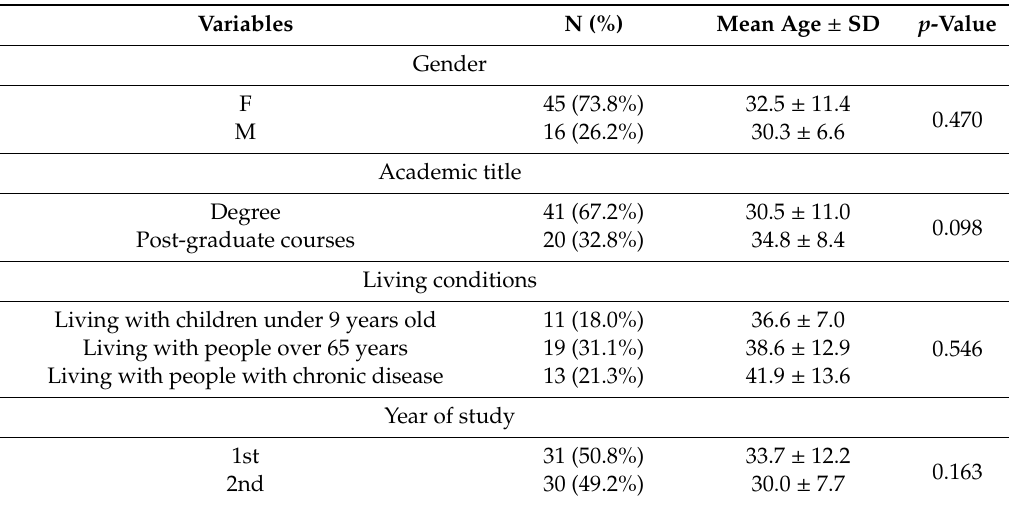
Table 1. Sample characteristics (number of participants, mean age, and p -value) stratified by gender, academic title, living conditions and year of study.